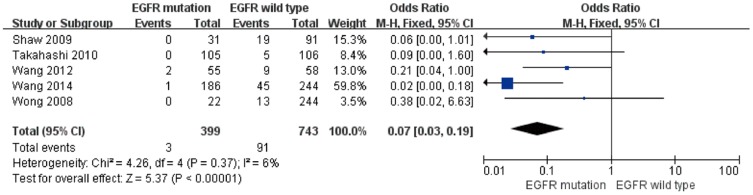
Forest plots of studies with an association between the EML4-ALK fusion gene and EGFR.